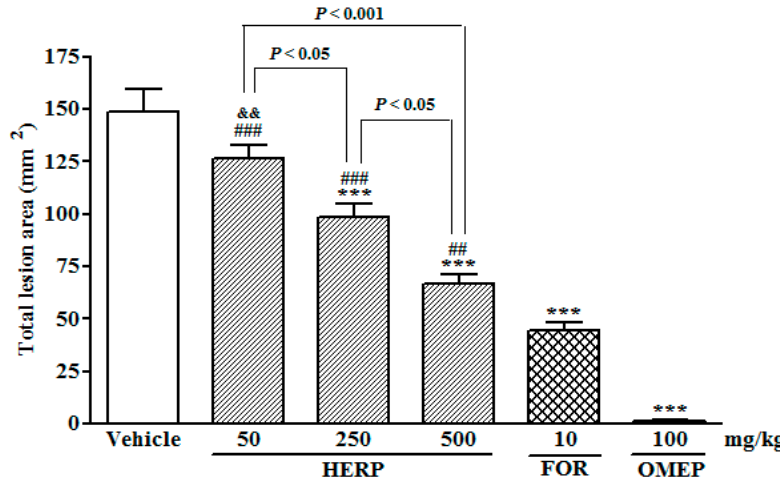
Figure 1. Effects of hydroalcoholic extracts of red propolis (HERP) and formononetin (FOR) on the ethanol-induced gastric damage; rats were pre-treated with a solution of 2% Tween 80 (vehicle), HERP (50–500 mg / kg), formononetin (10 mg / kg), or omeprazole (OMEP, 100 mg / kg) for 30 min prior to one hour treatment with absolute ethanol (1 mL). Total lesion areas were then determined and are presented as the means ± standard errors of the mean (SEM; n = 6 / group); ANOVA followed by Bonferroni’s test; *** p < 0.001 vs. vehicle group; ## p < 0.01 and ### p < 0.001 vs. OMEP group; && p < 0.01 vs. FOR group. Table 1. Effects of HERP and formononetin on ethanol-induced microscopic damage in gastric mucosa. Treatment (p.o.)